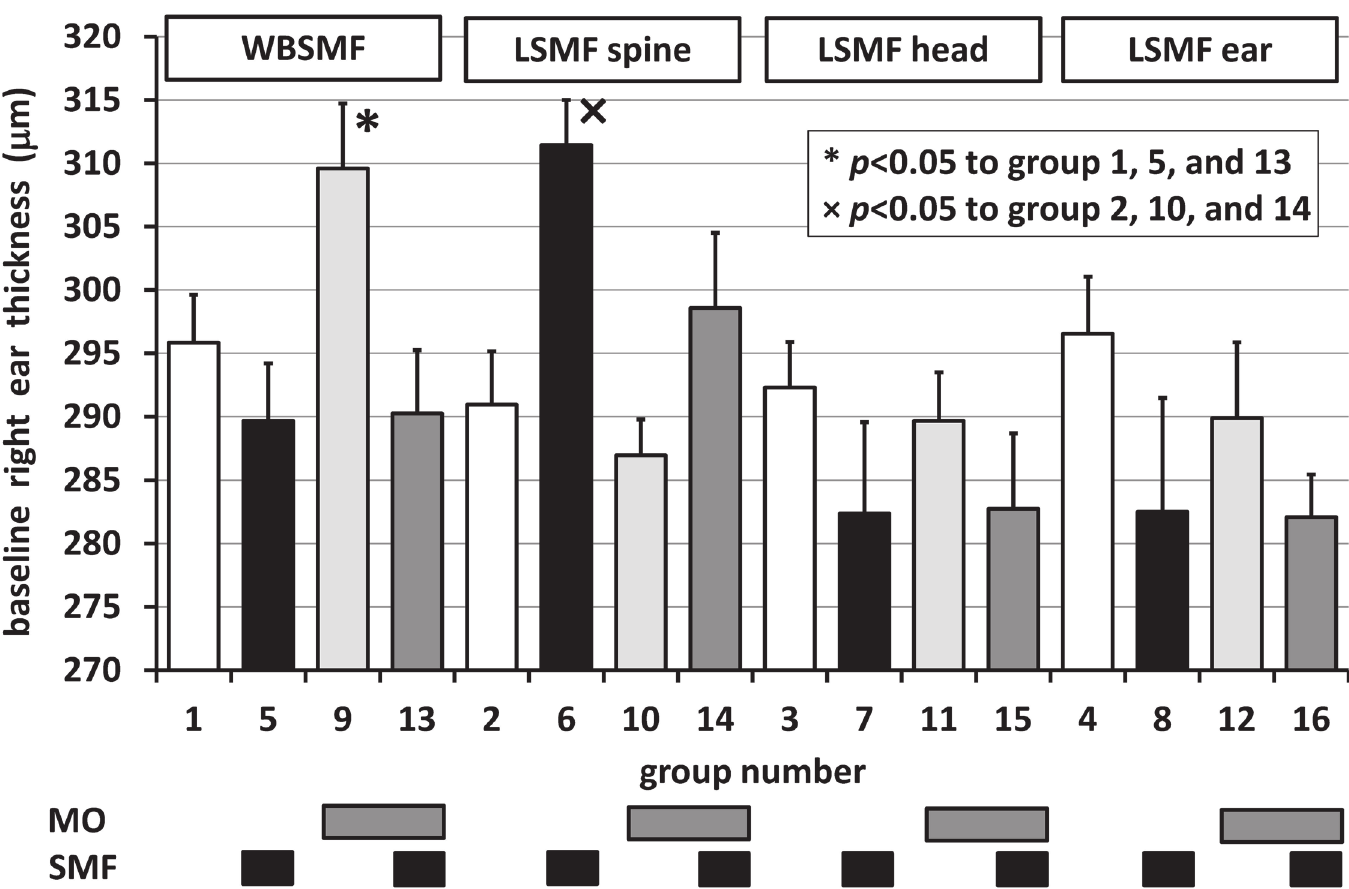
Fig 2. Baseline right ear thickness in μ m for different groups ( c.f. , Table 1). * and × refer to significant differences in multiple groups to Groups 1, 5, 13 and to Groups 2, 10, 14, respectively. Bars above the columns denote treatment types. Error bars show positive standard errors of the mean